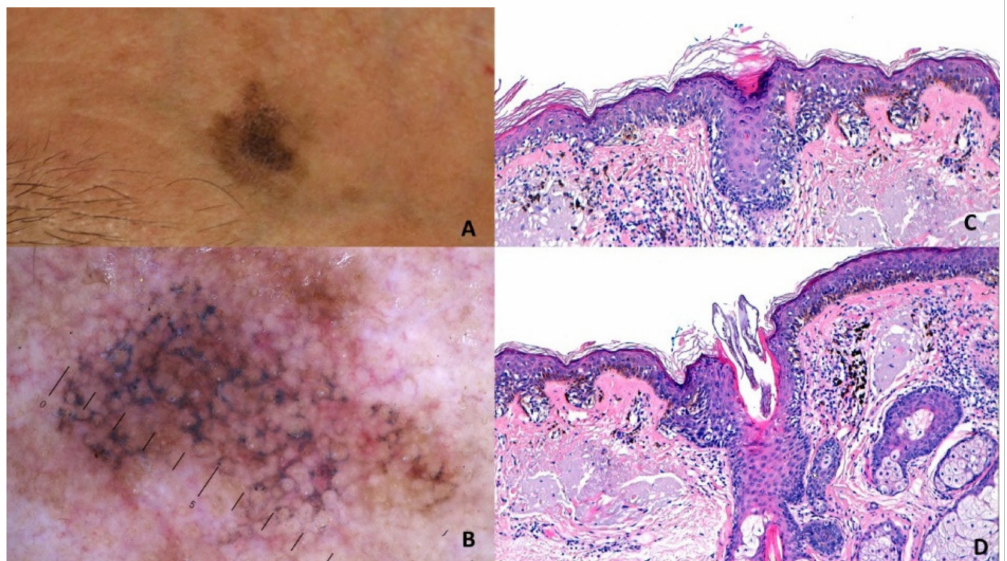
Figure 5. Lentigo maligna on the left temporal region of a 77-y old man. Panel A : asymmetric, irregularly pigmented macule. Panel B : polarized contact dermoscopy (Dermaview ® , Tre T Medical, Camposano, NA, Italy) shows asymmetry and multiple colors; asymmetric pigmentation of the hair follicles, dots, and annular-granular pattern. Panel C , D : Histology shows atypical melanocytes and irregular nests at the DEJ and in the epidermis with involvement of the hair follicles (correlate with the asymmetric pigmentation of the hair follicles); in the dermis, there is prominent solar elastosis, melanophages (correlate with the dots and annular-granular pattern) and a discrete lymphohistiocytic infiltrate. (Panel C , D : HE, 400 ×